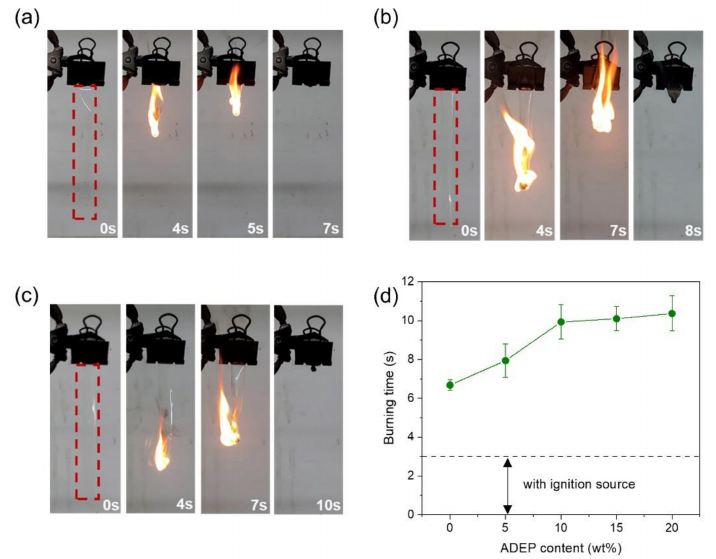
Figure 3. Digital photographs of the vertical burning test for ( a ) the pristine PAN film and the composite films containing ( b ) 5 wt% and ( c ) 10 wt% ADEP. The films were ignited for 3 s and ( d ) the burning time as a function of the content of ADEP was